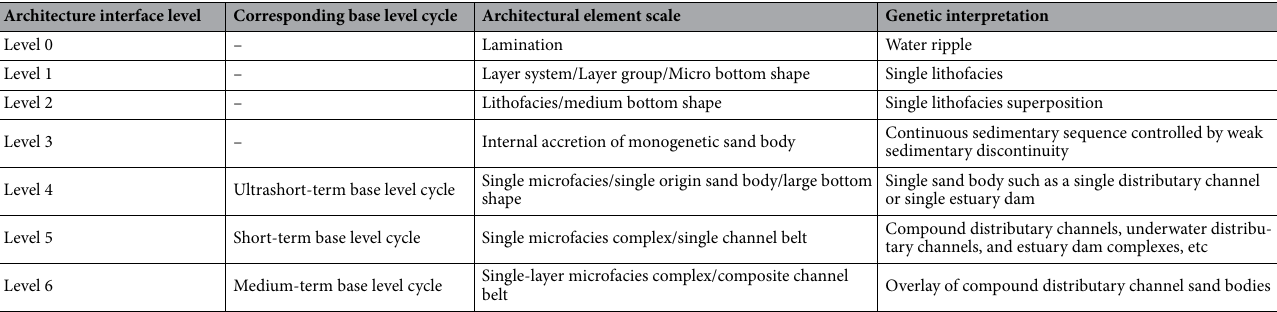
Table 1. Grade division scheme of architectural